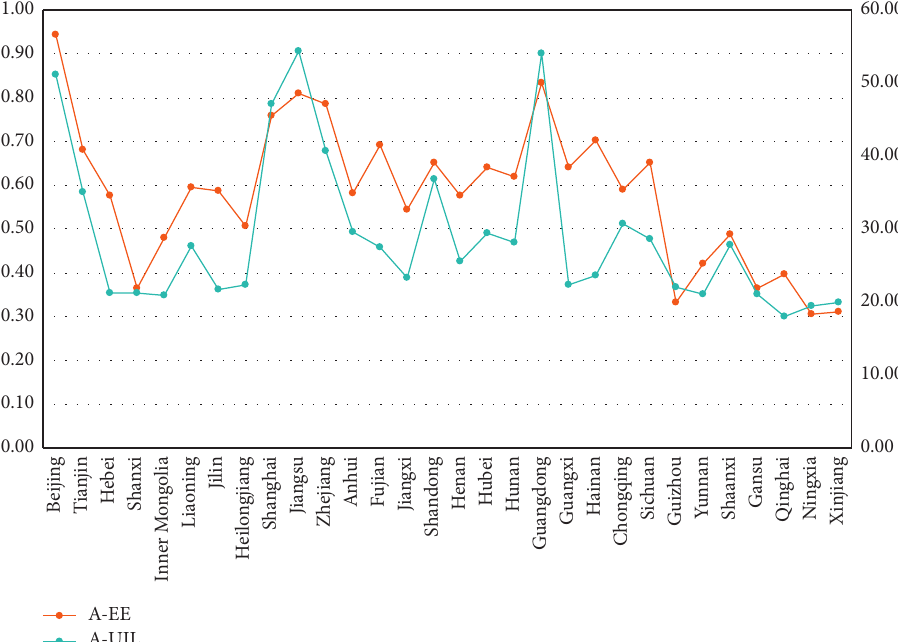
Figure 3: Comparison of the urban innovation level and ecological efficiency average in 30 provinces and cities of China ((1) Urban innovation water average (A-UIL): average value of urban innovation level of 30 provinces and cities in China. (2) average ecological efficiency (A-EE): average eco-efficiency of 30 provinces and cities in